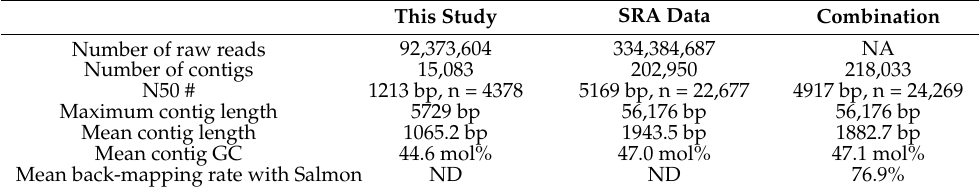
Table 1. Transcriptome statistics. Raw reads from this study and from the Sequence Read Archive were assembled into contigs, representing the transcriptome. Transcriptomes were then combined and finally, reads from this study were mapped back to the combined